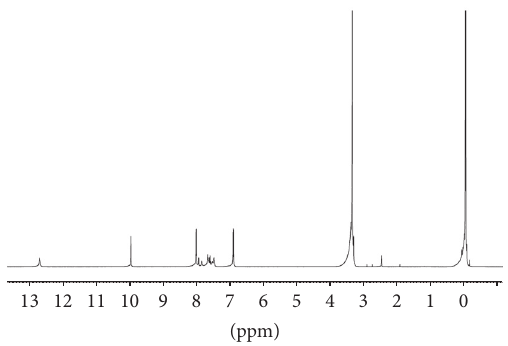
Figure 4: 1 H NMR spectrum of